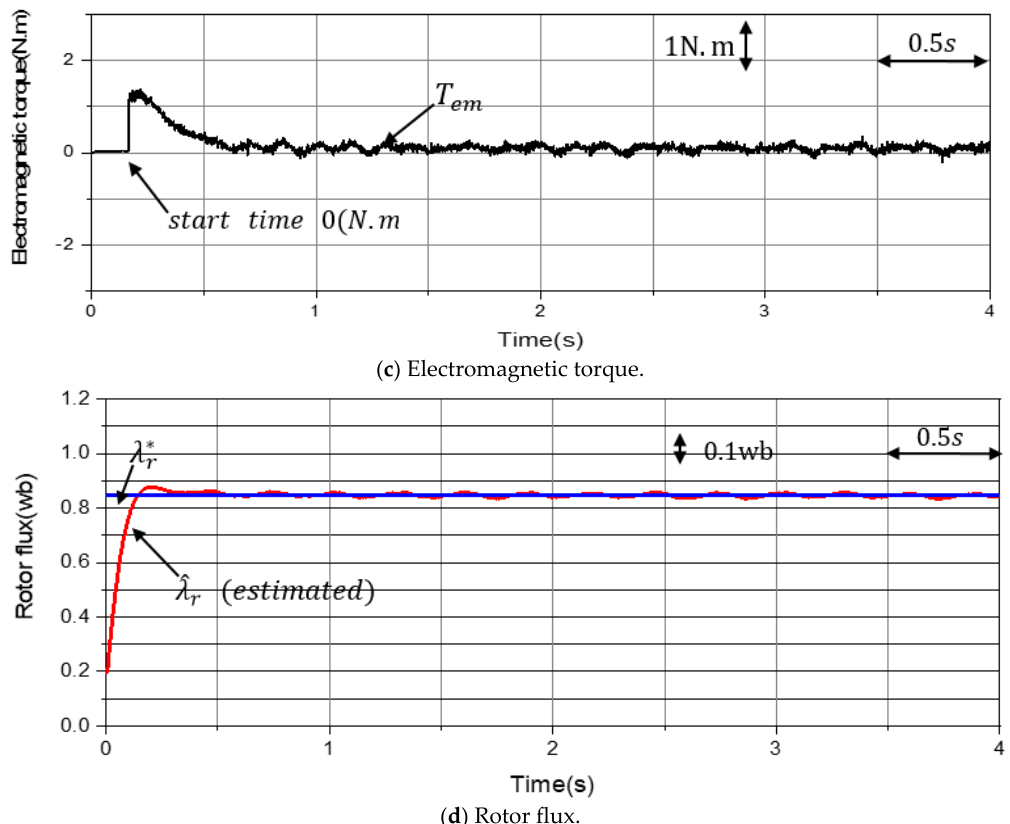
Figure 6. Dynamic performance of five-phase IM drive at low speed Figure 6 . Dynamic performance of five-phase IM drive at low speed operation